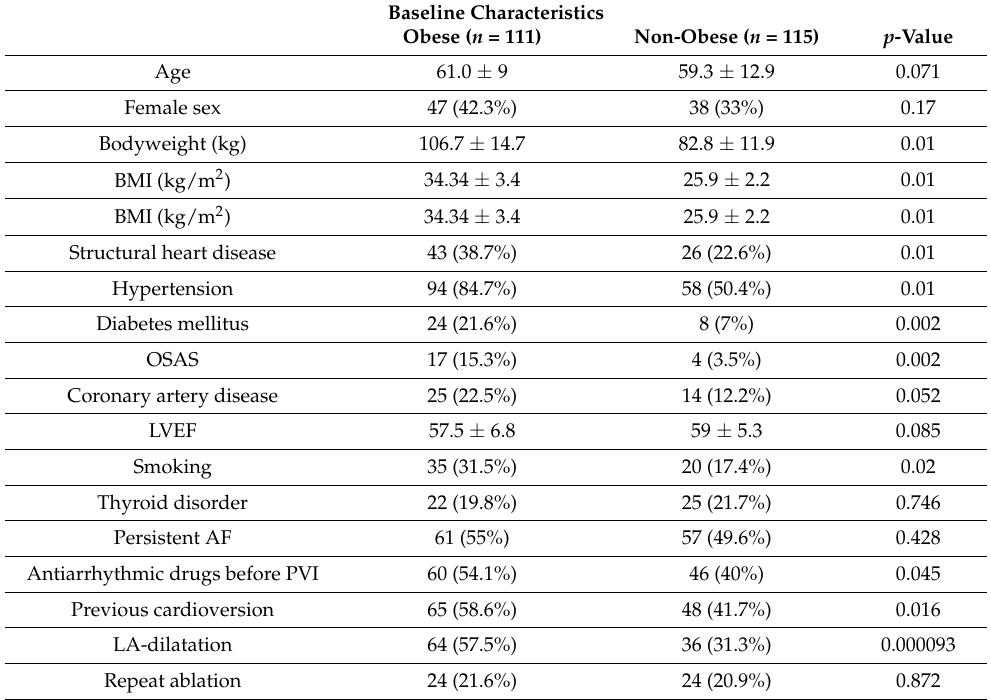
Table 1. Patient characteristics at